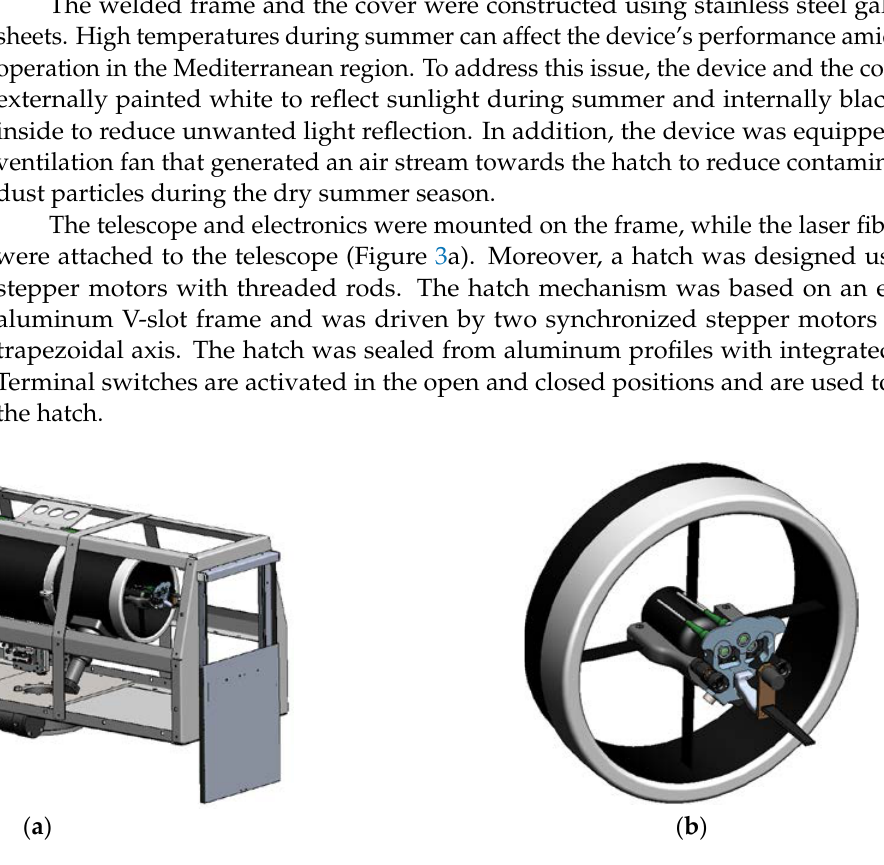
Figure 2. CAD images of the instrument’s ( a ) external and ( b ) internal configuration (dimensions in mm).